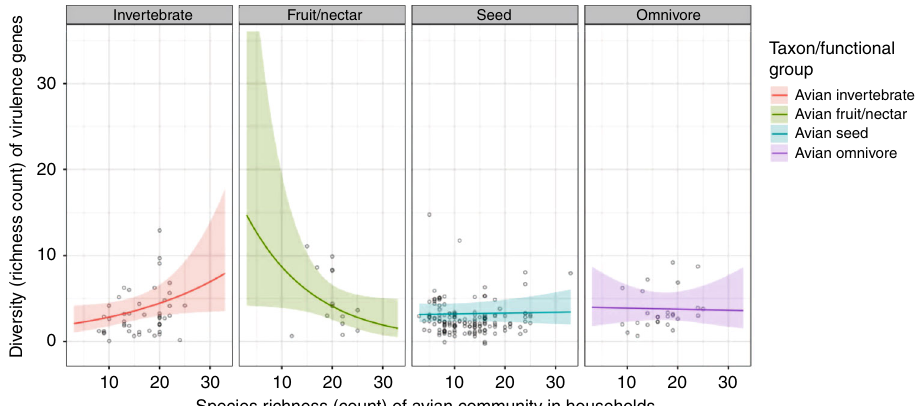
Fig. 1 Virulence gene diversity and avian species richness. Fit of the Poisson GLMM, modelling how diversity (richness) of virulence genes in avian hosts ( n = 239) varies as a function of avian host community richness and functional group membership. Coloured lines represent different avian functional groups, and shading on either side of each line represents 95% con fi dence intervals